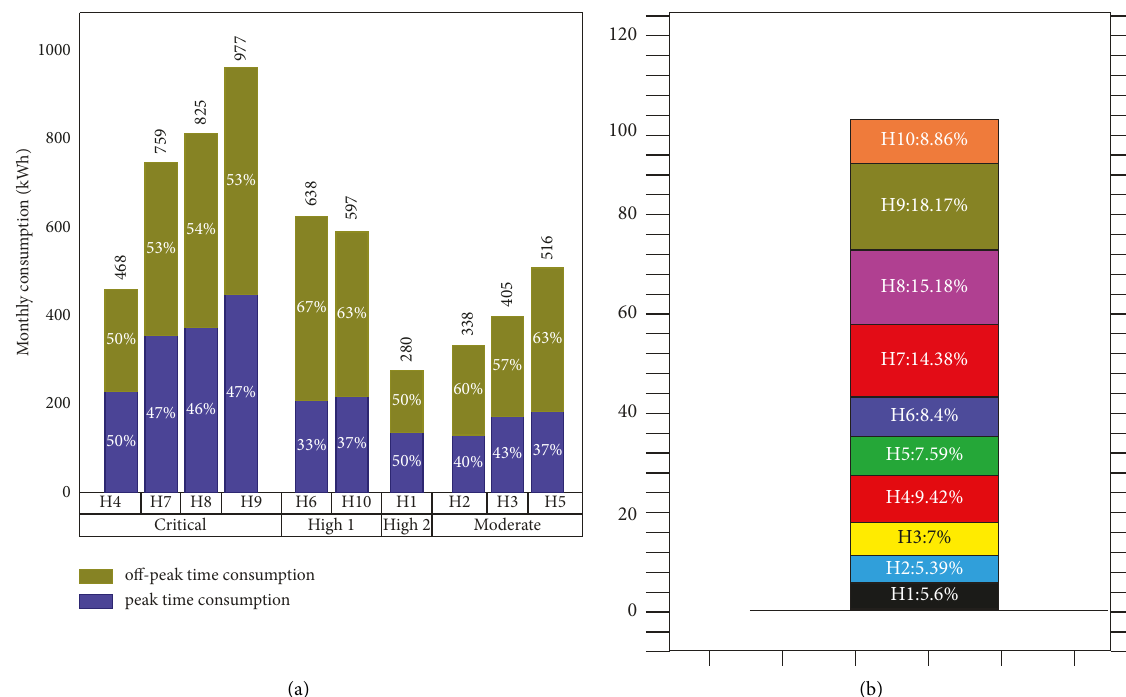
Figure 11: Monthly on-peak and off-peak time consumption of each customer at house level and utility level for a nonsummer